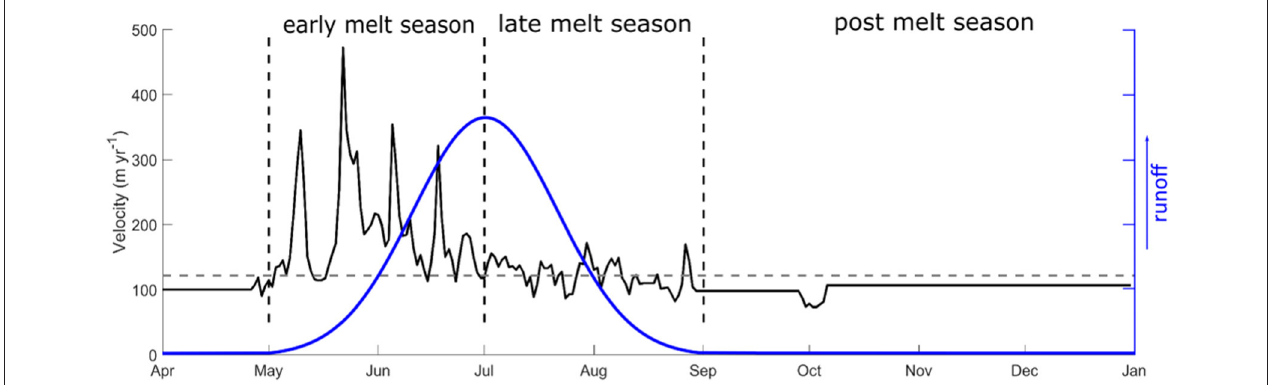
FIGURE 2 | Greenland Ice Sheet velocity and runoff. Twenty-four hour mean horizontal velocity (solid black line) during 2010 at Leverett site 3 [20km inland from the ice margin; see Sole et al. (2013)] and idealised runoff hydrograph (solid blue line), showing the early, late, and post-melt season periods, as described in text, separated by dashed vertical lines. As discussed in text, the positions of the seasonal boundaries are based on the runoff hydrograph, not the time of year. Dashed horizontal grey line indicates mean annual ice